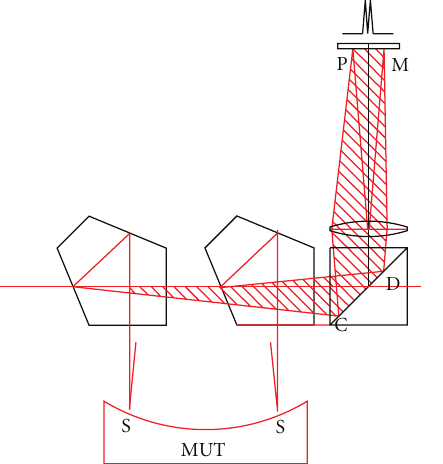
Figure 2: Beams’ lateral motion on a scan in the pentaprism mode.